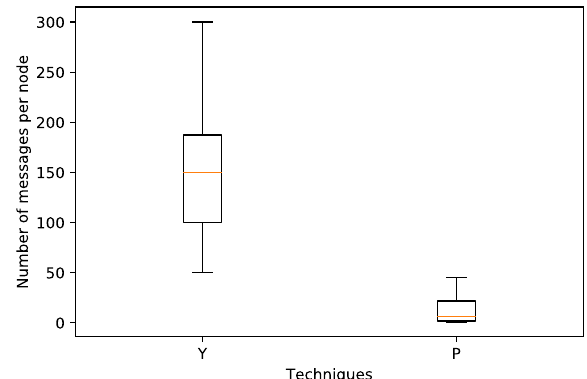
Fig. 4 Numbers of messages per node using each method on a random graph with D = 10 . On the horizontal axis Y and P denote the YTQ and pruning methods respectively